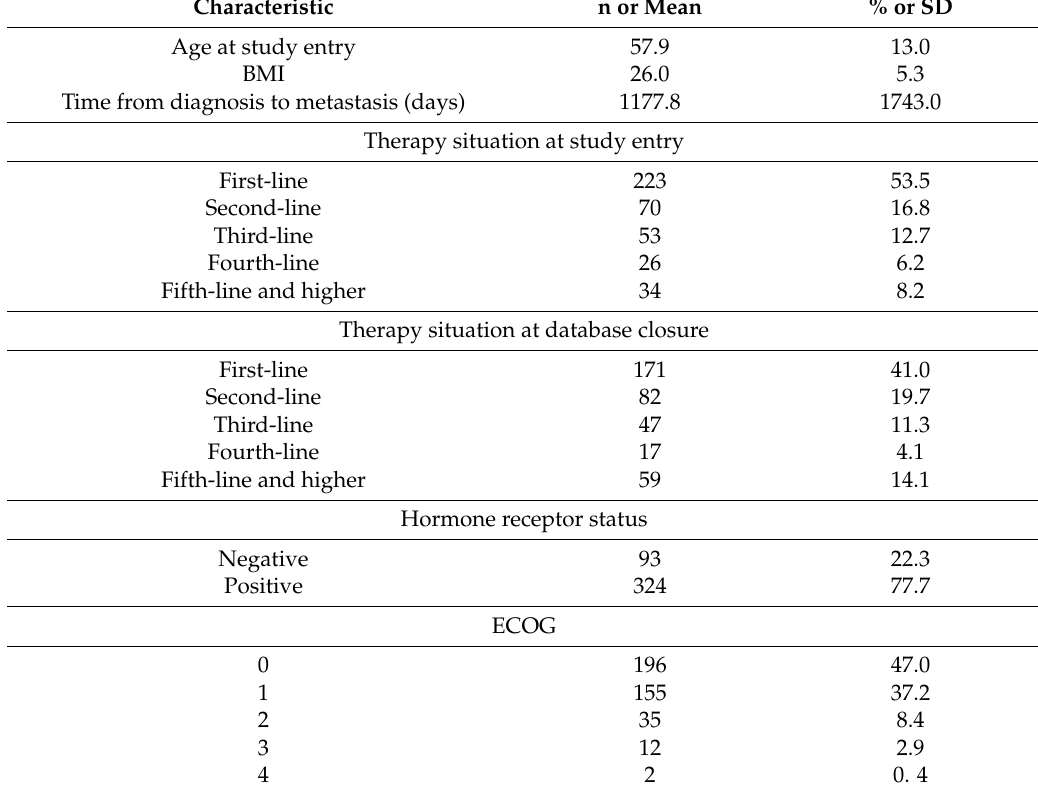
Table 1. Patient characteristics at baseline.